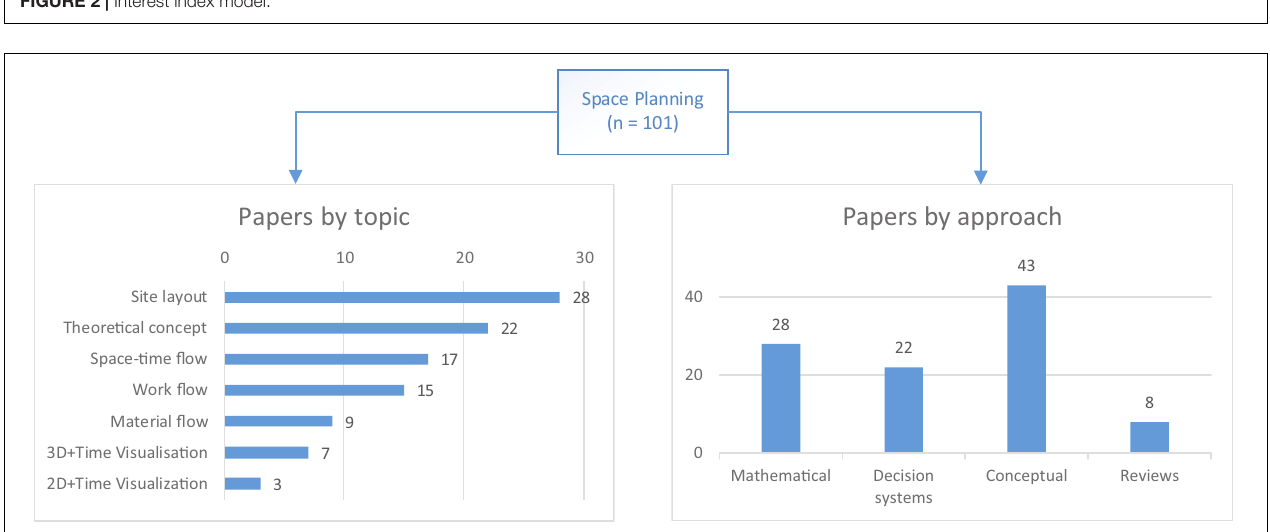
FIGURE 3 | Identified publications grouped by topic and